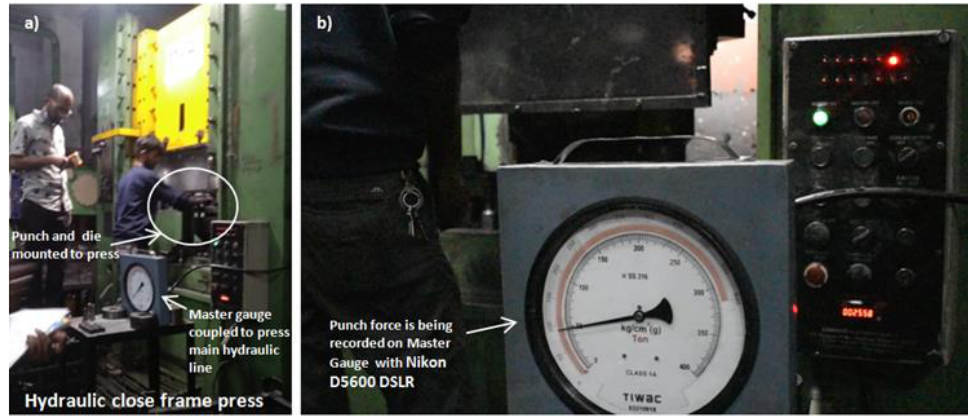
Figure 6. ( a ) Close frame 600 Ton hydraulic press; ( b ) the master gauge and experimental set-up (Courtesy: S. S. Industries, Bangalore, India).